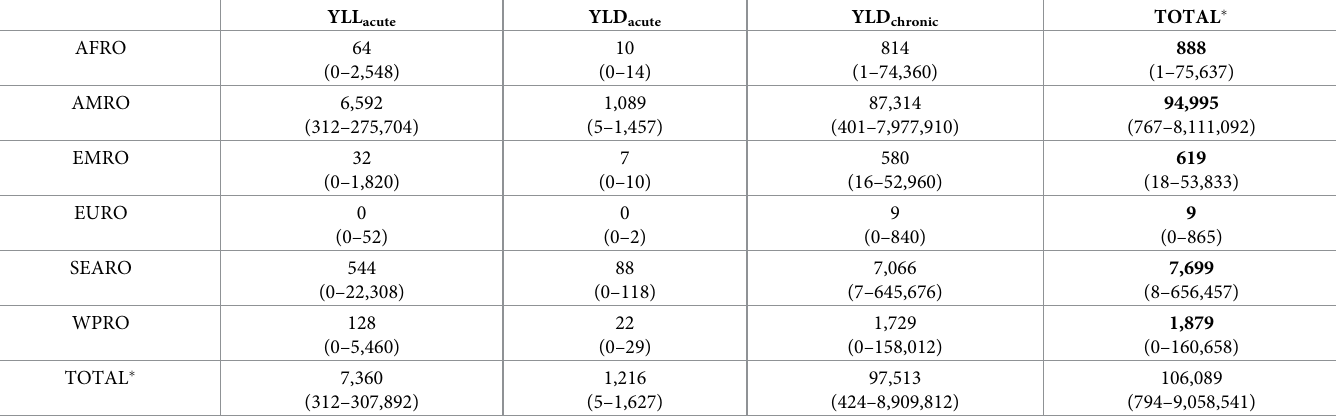
Table 3. DALY estimates for